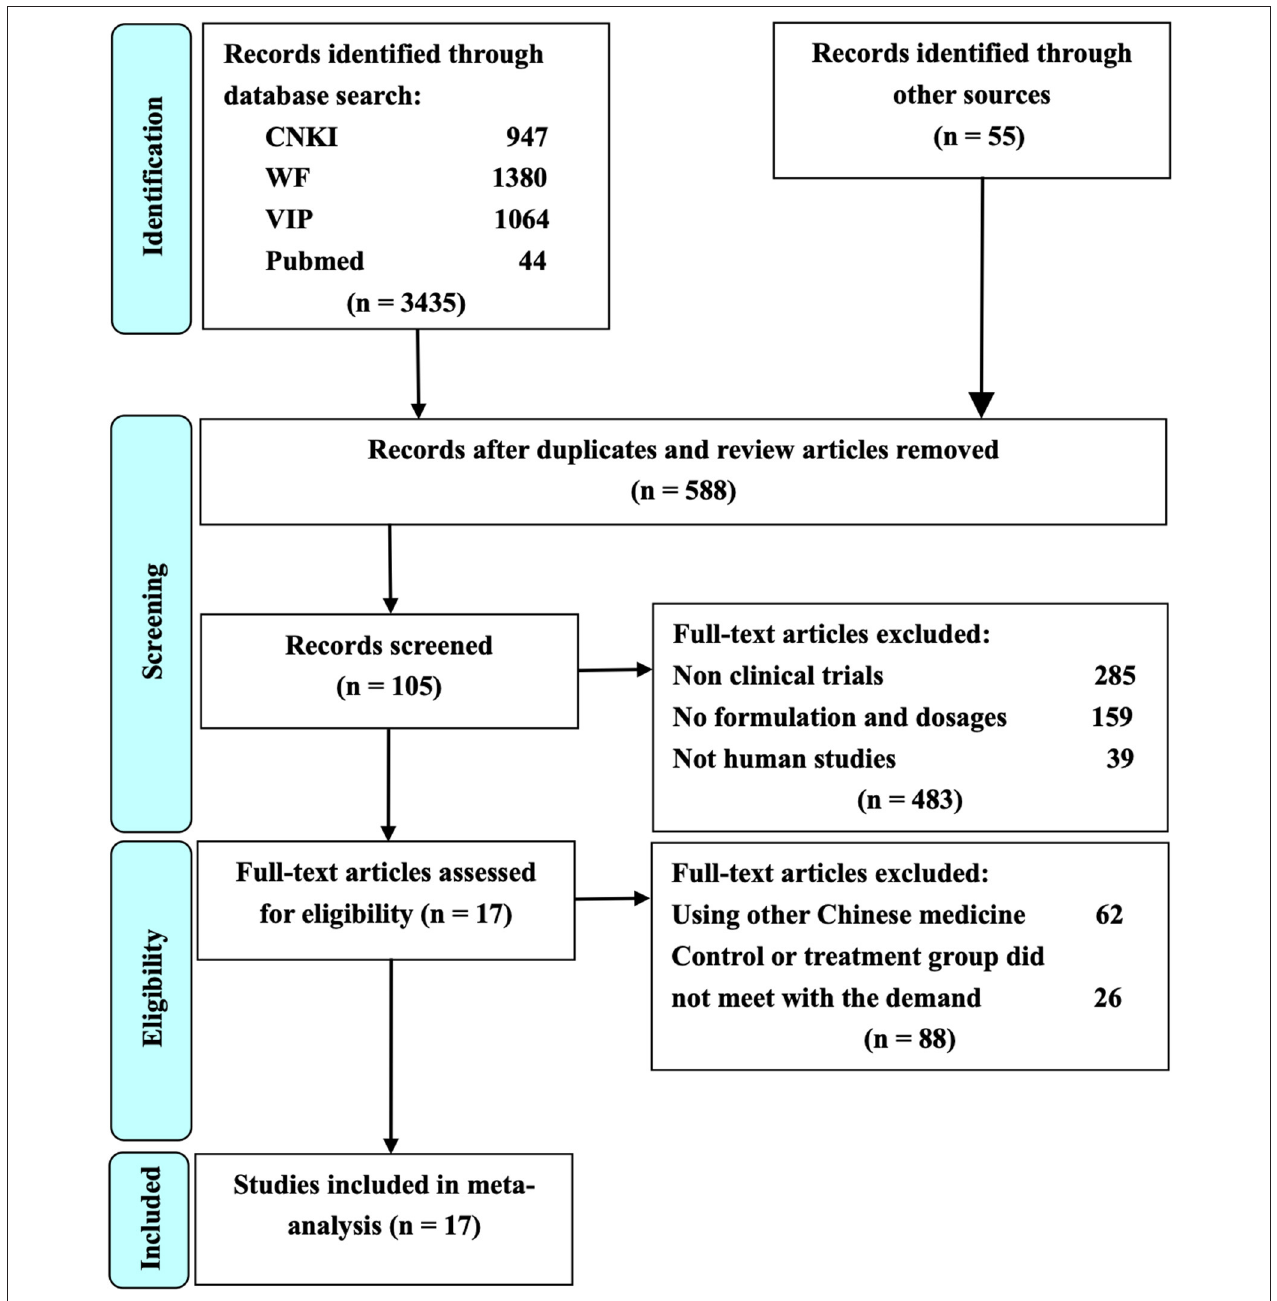
FIGURE 1 | The study selection process for the identification of eligible studies. CNKI is China National Knowledge Infrastructure; WF is Wangfang Data; VIP is Chinese Scientific Journal Database; Other sources are Medline, Chinese Biomedical Literature Database, Cochrane Library, Embase, Google Scholar, Sino-Med, and Chinese Science Citation